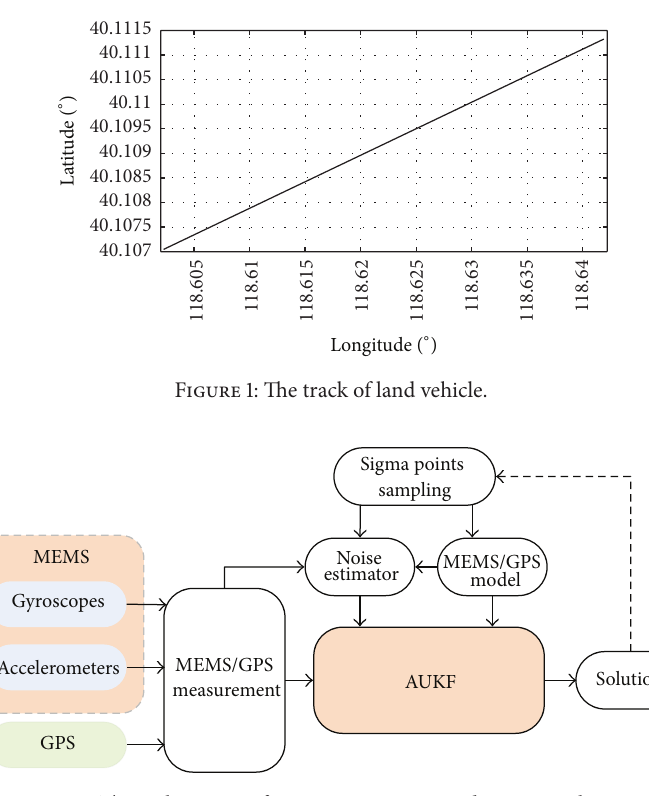
Figure 2: The architecture of MEMS/GPS integrated system with